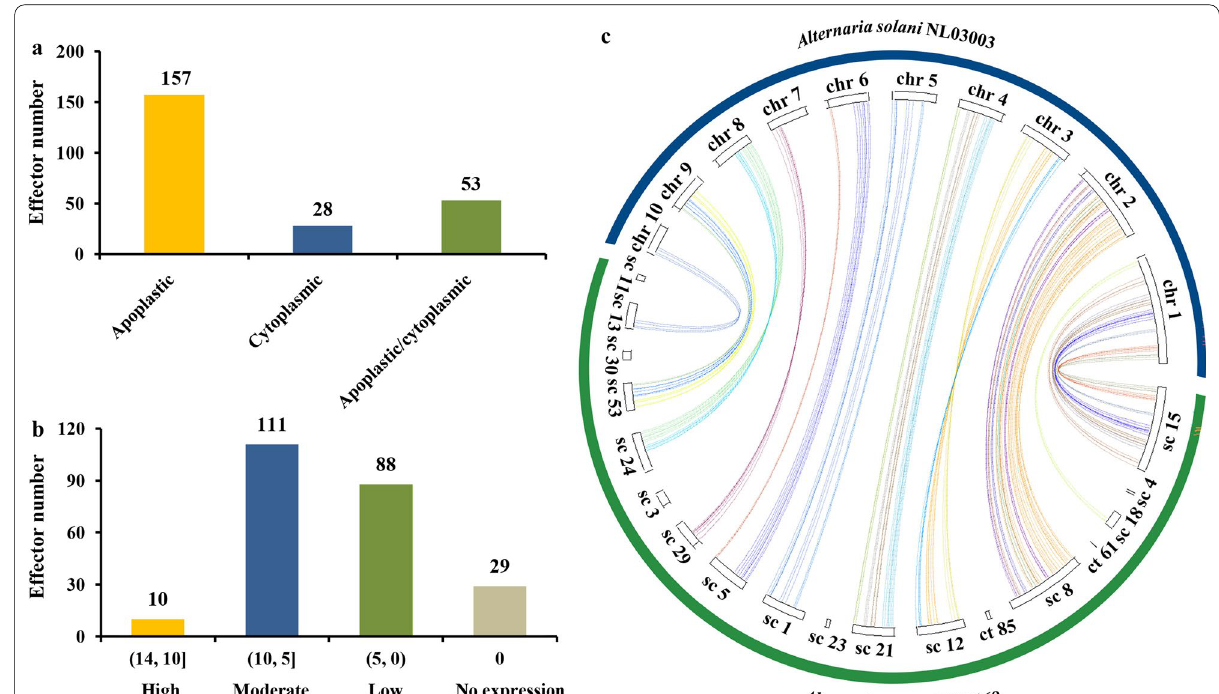
Fig. 1 Candidate effector proteins in A. solani (AsCEPs). a Histogram showing effector types based on distinct targeting sites in plant cells. b Histogram showing the expression levels of AsCEPs genes. AsCEPs genes were divided into four subsets according to the Log 2 (TPM Collinearity of AsCEP genes between genomes of strains NL03003 and HWC168. Lines connect AsCEP gene